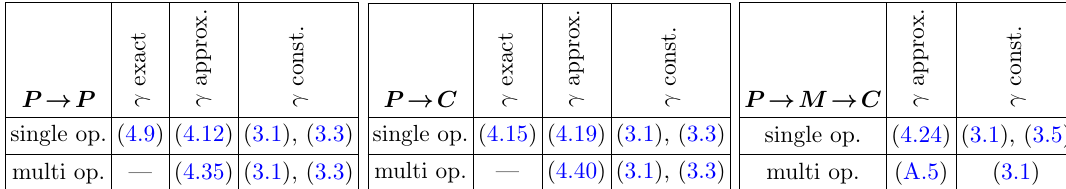
Figure 4 . Example of full mixing from O Hd into O (1 ; 8) beween 20 TeV and (cid:22) EW in our framework, qd including mixing among parent and child operators, relative to the values generated for ^ (cid:13) P ! C (cid:17) const :; ^ (cid:13) P = ^ (cid:13) C = 0 (denoted by C qd; 0 and shown blue dashed) considered in [15].